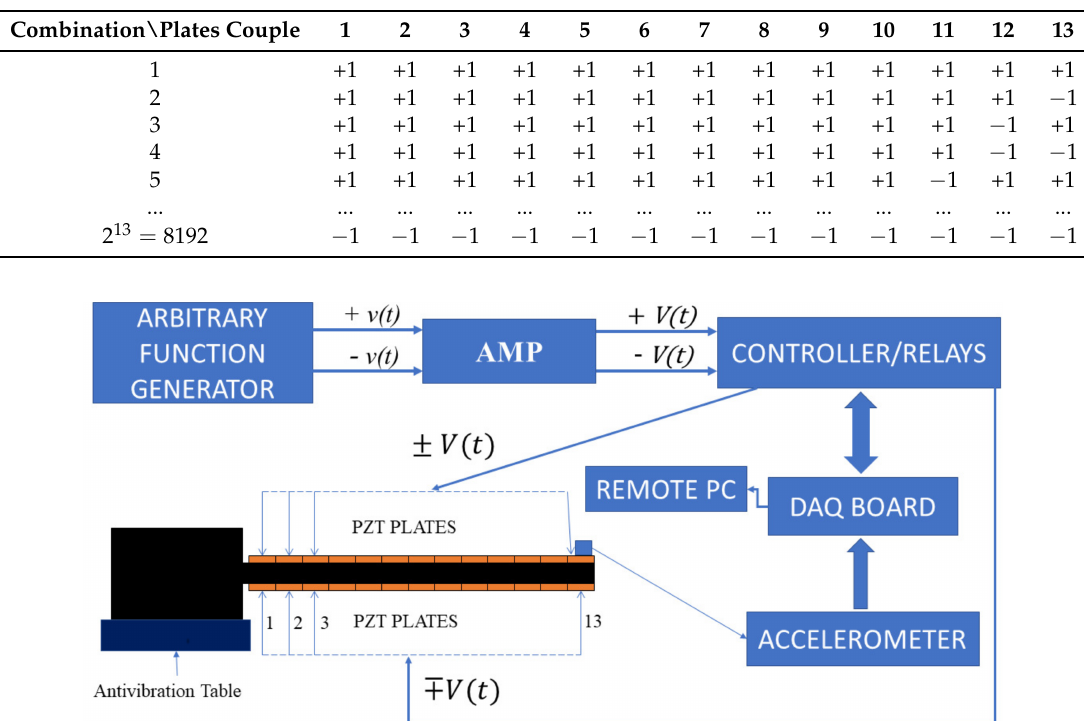
Table 2. Combinations of the potential distribution.